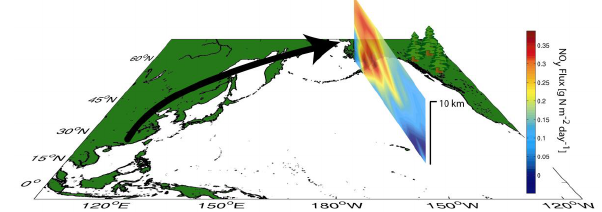
581 Fig. 5. Daytime flux of reactive nitrogen [gN m 2 day − 1 ] calculated Figure 5 : Daytime flux of reactive nitrogen [gN m 2 day -1 ] calculated using all available 582 using all available observations of gas-phase NO y and wind-speed observations of gas-phase NO y and wind-speed gridded into 5 latitude x 2 km altitude bins. 583 Observations were filtered to remove strong stratospheric influence (O 3 /CO >1.25). 584 gridded into 5 latitude × 2km altitude bins. Observations were fil- 585 tered to remove strong stratospheric influence (O 3 /CO >